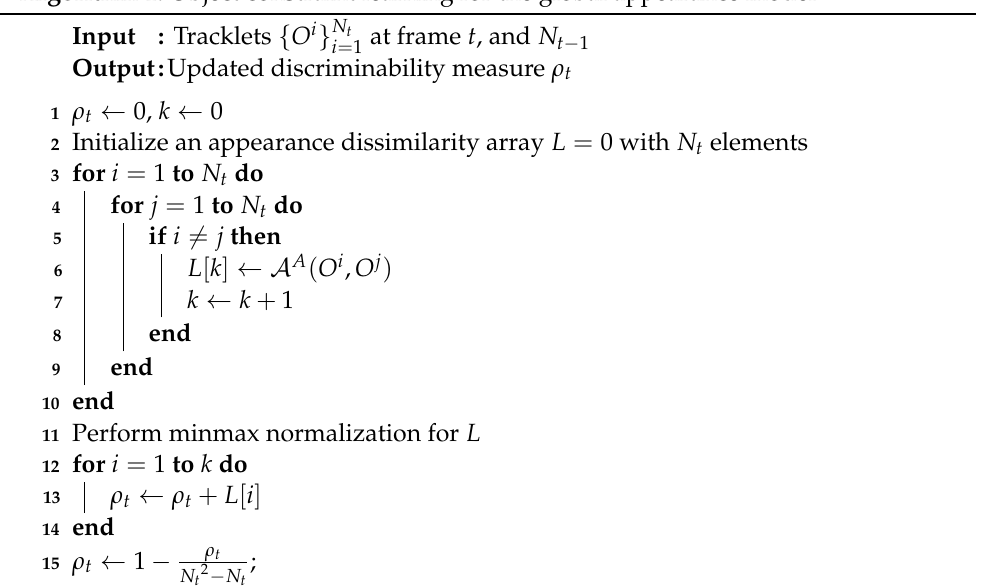
Figure 6. Examples of appearance changes in two different sequences. ( a ) Low appearance variation of a tracked object during tracking. ( b ) Abrupt appearance variation of an occluded object at frame 436. Algorithm 1: Object constraint learning for the global appearance